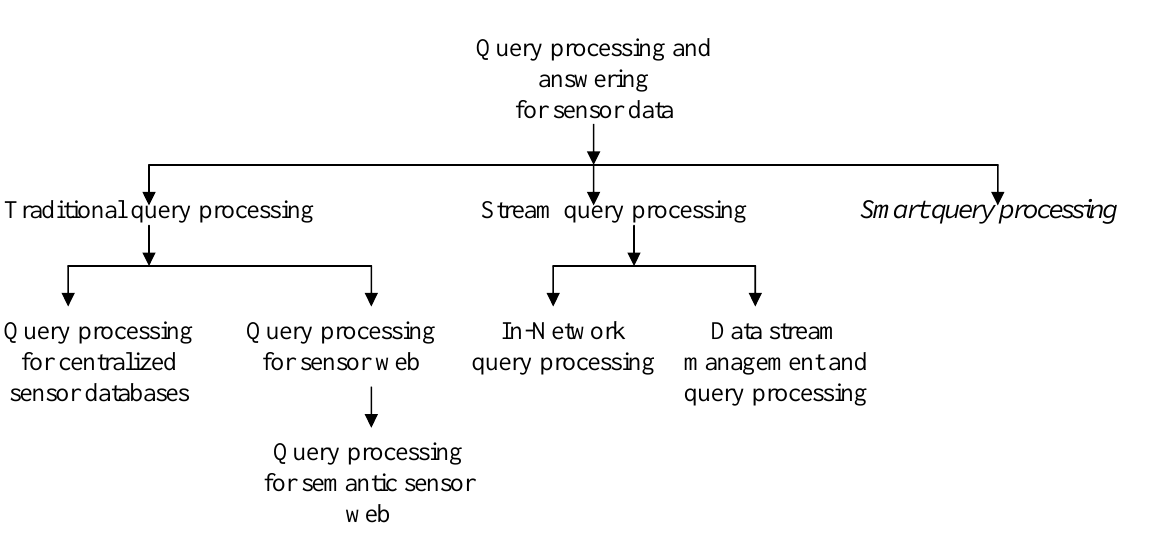
Figure 2. Classification of query processing based on sensor data